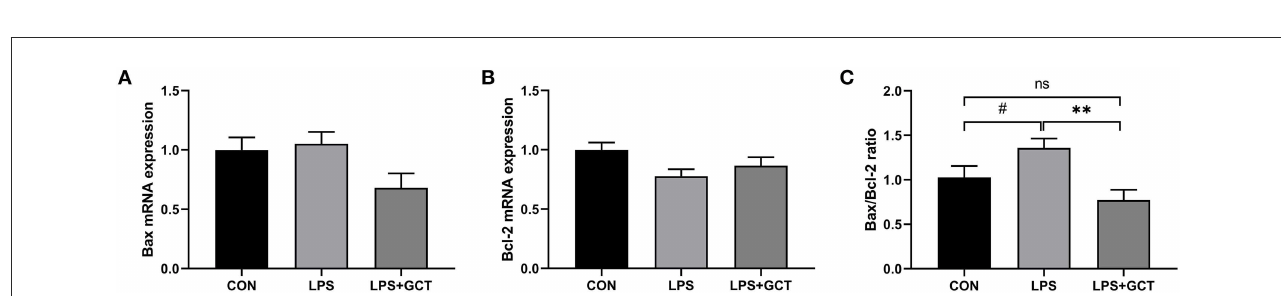
FIGURE8 Effects of dietary Galla Chinensis tannin (GCT) supplementation on apoptosis genes in livers of broilers under lipopolysaccharide (LPS)-challenge. (A) BCL2-Associated X ( Bax ); (B) B-cell lymphoma-2 ( Bcl-2 ); (C) Bax/Bcl-2 ratio. CON, fed on a basal diet and intraperitoneally injected with saline solution; LPS, fed on a basal diet and intraperitoneally injected with LPS; LPS + GCT, fed on a basal diet supplemented with 300 mg/kg GCT and intraperitoneally injected with LPS. Values are presented as mean ± standard error ( n = 6). ** p < 0.01, # 0.05 < p < 0.10; ns,